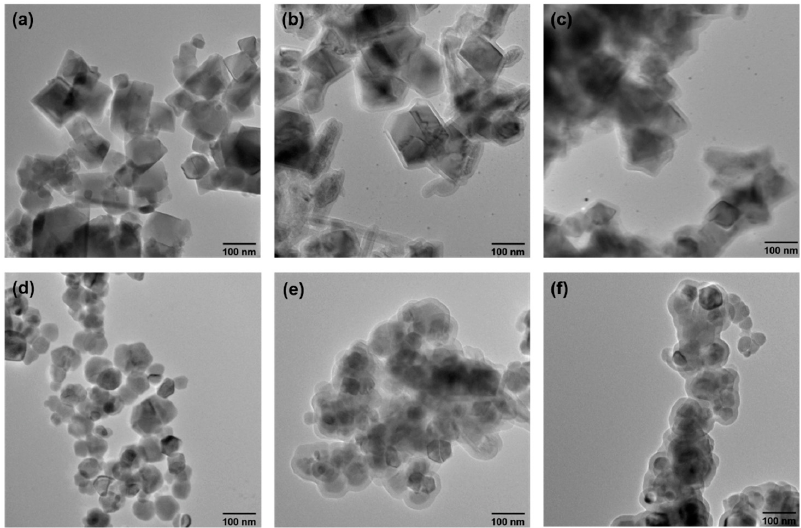
Figure 4. TEM images of the nanoparticle samples employed in this research: ( a ) cuboid Fe 3 O 4 , ( b ) cuboid Fe 3 O 4 @SiO 2 , ( c ) Cuboid Fe 3 O 4 @SiO 2 functionalized with corrole molecules, ( d ) Spheroid Fe 3 O 4 , ( e ) Spheroid Fe 3 O 4 @SiO 2 , ( f ) Spheroid Fe 3 O 4 @SiO 2 functionalized with corrole